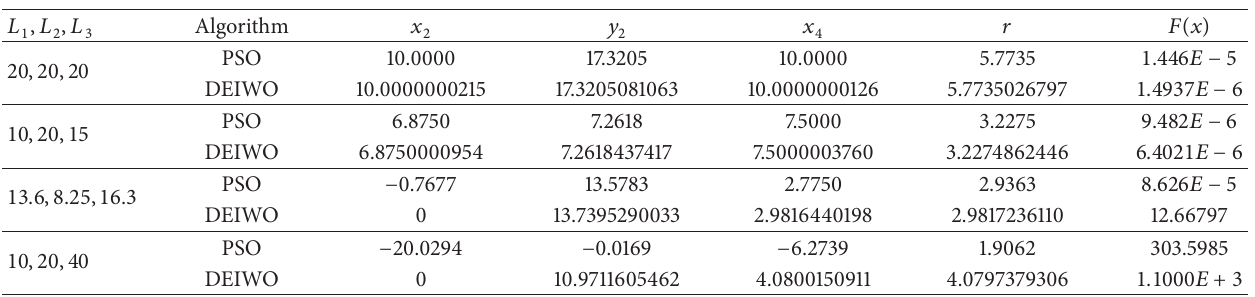
Table 14: Results of solving geometric